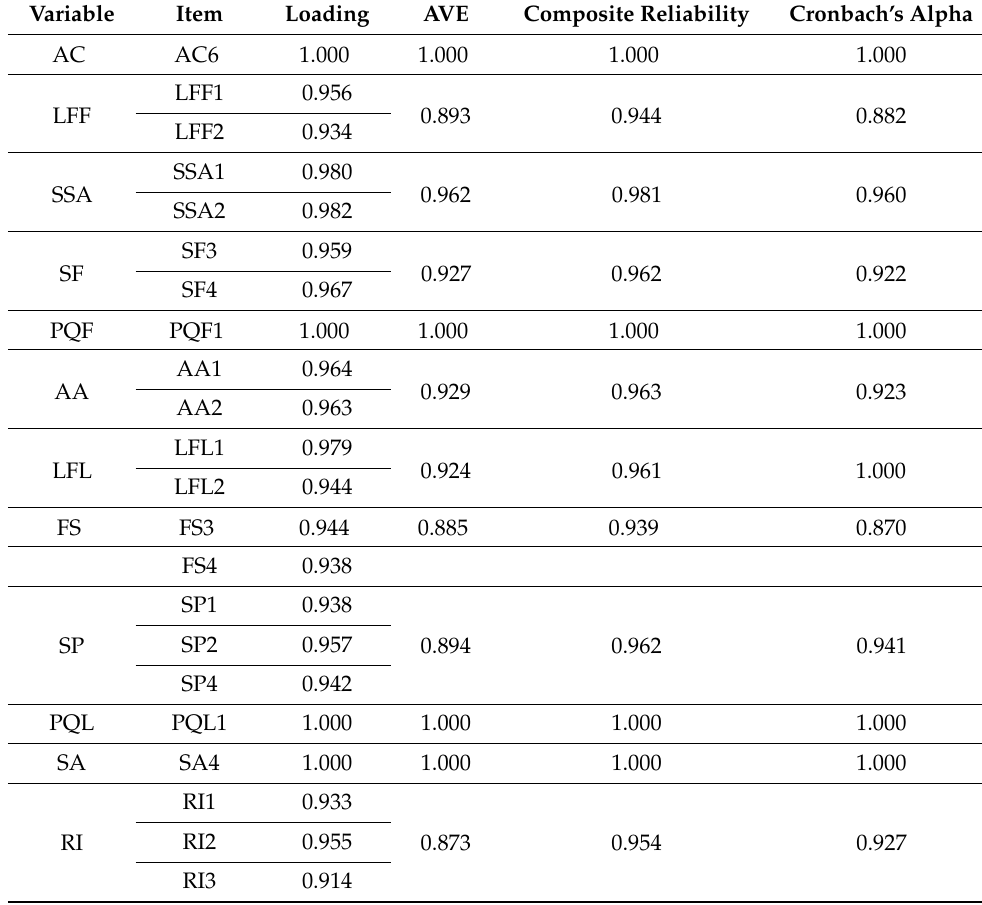
Table 2. Convergent validity and reliability test